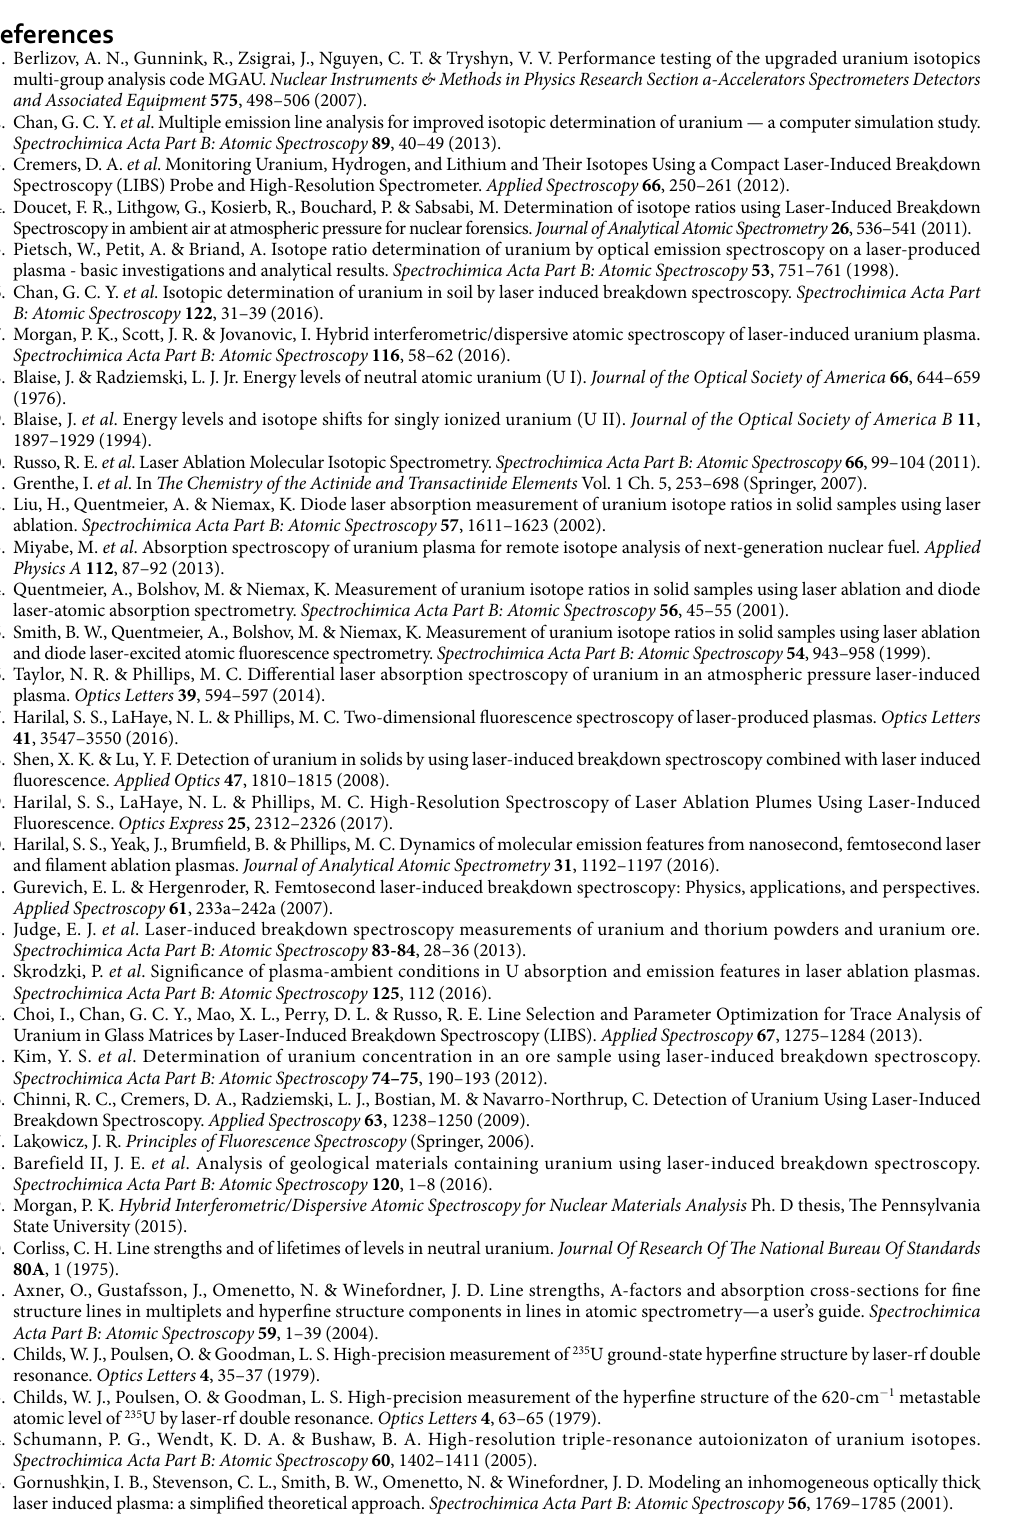
calculated hyperfine transitions are provided in Supplementary Table S1 for the 235 U I 394.38 nm transition and Supplementary Table S2 for the 235 U I 404.28 nm transition (Supplementary information). The spectral model has limitations due to the spatial and temporal dependence of the plasma conditions. Specifically, the spectral model does not account for radiative transport effects arising from a non-uniform spatial distribution of density and temperature along the observation line-of-sight, which may affect both the absorption and the emission channels of the LIF process 35 . In addition, possible effects of optical pumping are not included in the